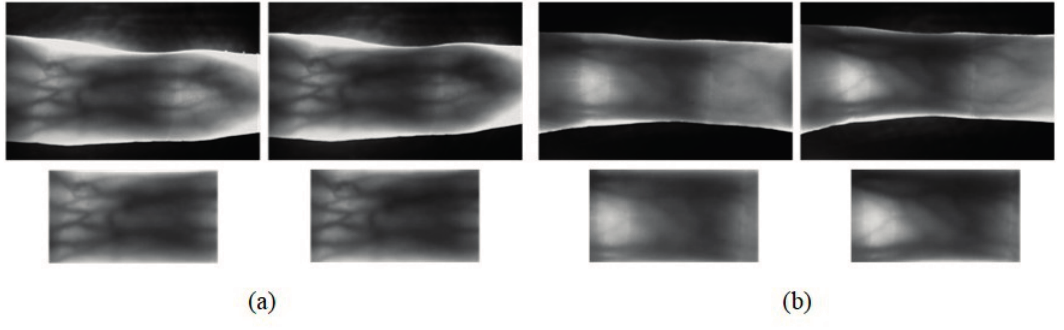
Figure 8. Two groups of images, ( a ) and ( b ), and their ROIs from UTFVP